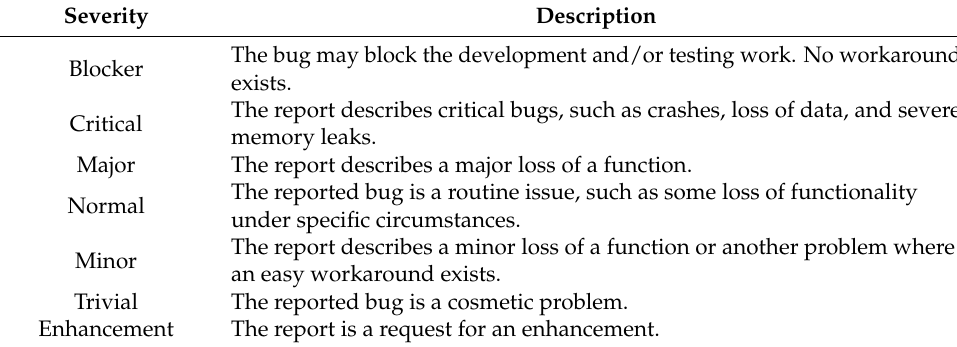
Table 1. Severity levels used in